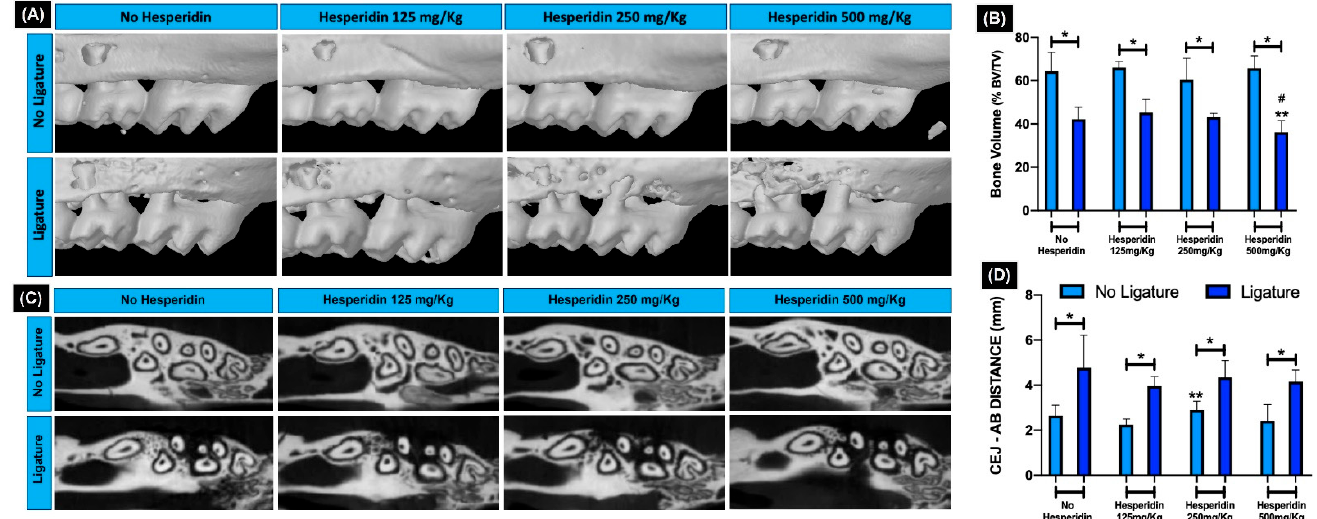
Figure 3. Two and three-dimensional analysis of alveolar bone. ( A ) 3D and ( C ) 2D rendering of maxillae showing bone levels. ( B ) Graph expresses the average percentage of bone volume (BV) to total volume (TV) in each experimental group analyzed using µCT, showing significant bone loss promoted by ligature in all groups. Treatment with hesperidin at 500 mg/kg significantly decreased bone volume compared to the lowest concentrations of hesperidin. * p < 0.05 comparing group with and without ligature; ** p < 0.05 compared to the group ** 125 mg/kg + ligature and 250 mg/kg + ligature . The 3D ( A ) and 2D ( C ) representative images show alveolar bone integrity verified in all groups of animals that did not receive ligature, while in the other groups subjected to experimental periodontitis, bone reabsorption can be observed. Correlated to these findings, the linear measure- ment of cement-enamel junction (CEJ) distance showed a higher bone loss in the ligature groups ( D ). * p < 0.05 comparing group with and without ligature. ** p < 0.05 comparing no ligature groups HE 125mg and 250 mg/kg.